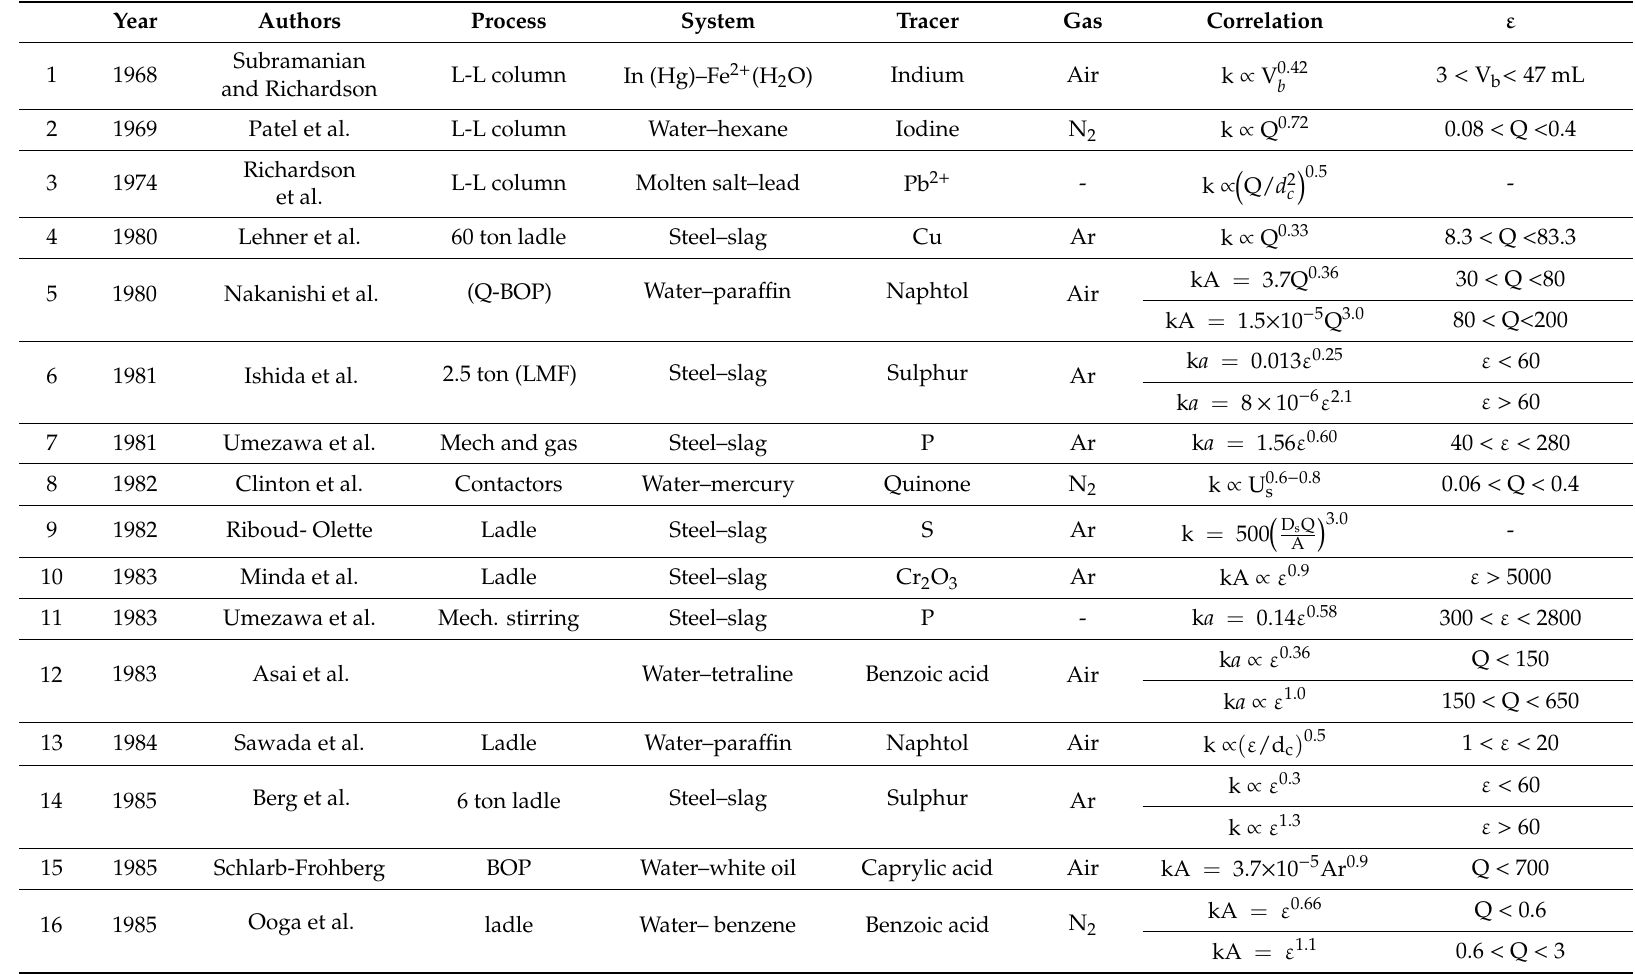
Table 2. Correlations between mtc (or vmtc ) and stirring energy ε (W / ton) or Q (Nl /